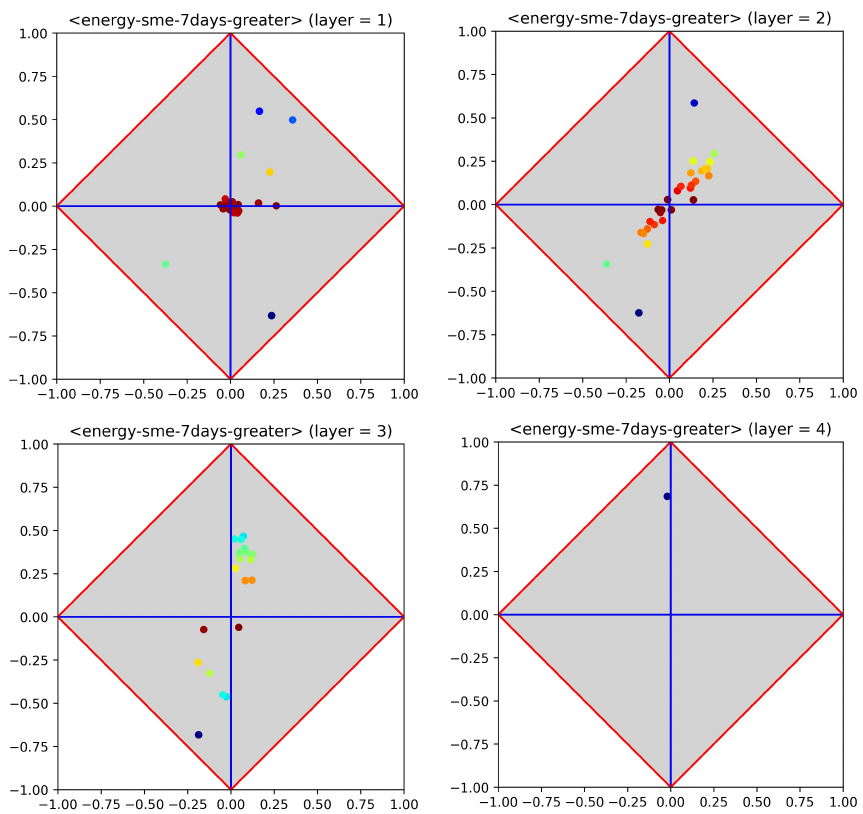
Figure 8. Hidden layers of an MLP trained on the dataset relating to enterprise customers (full set of features). The focus was on predicting whether the next-hour load would be greater than the previous